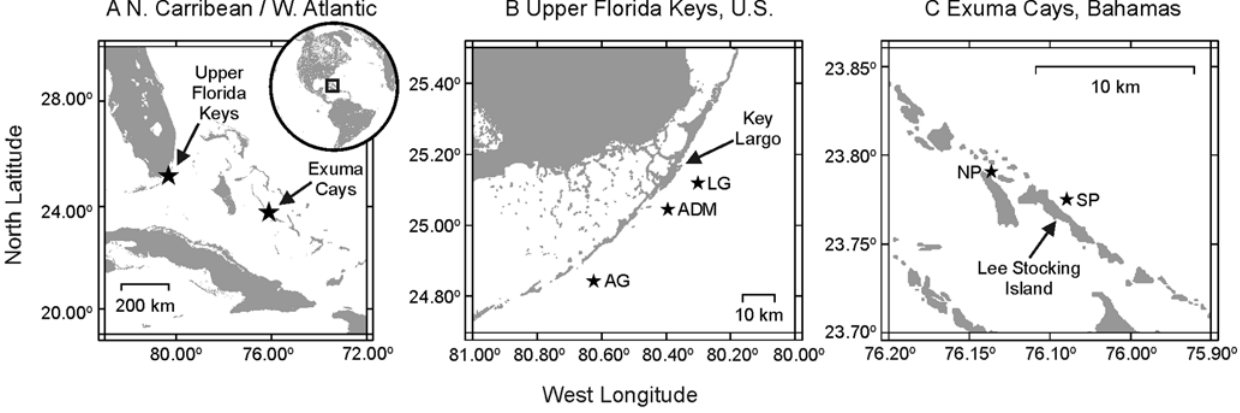
Figure 1. Maps of coral reefs sampled in this study. Regional (A) and local (B–C) maps of collection sites for Montastraea faveolata and M. annularis . Reef abbreviations are as follows: Upper Florida Keys (U.S.): LG=Little Grecian Reef, ADM=Admiral Patch Reef, AG=Alligator Reef; Exuma Cays (Bahamas): NP=North Norman’s Patch Reef, SP=South Perry Reef.